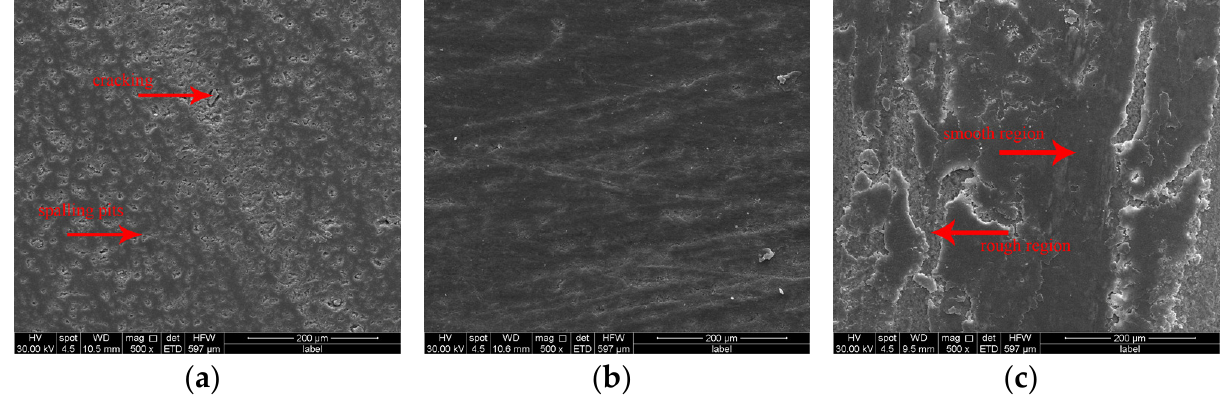
Figure 6. SEM images of worn surfaces of the SN20 pins at the following different speeds in artificial